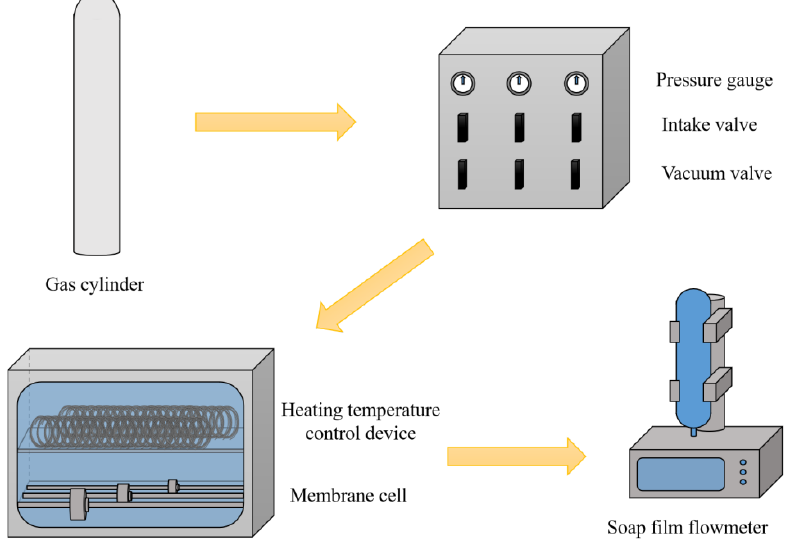
Figure 2. Schematic diagram of the experimental